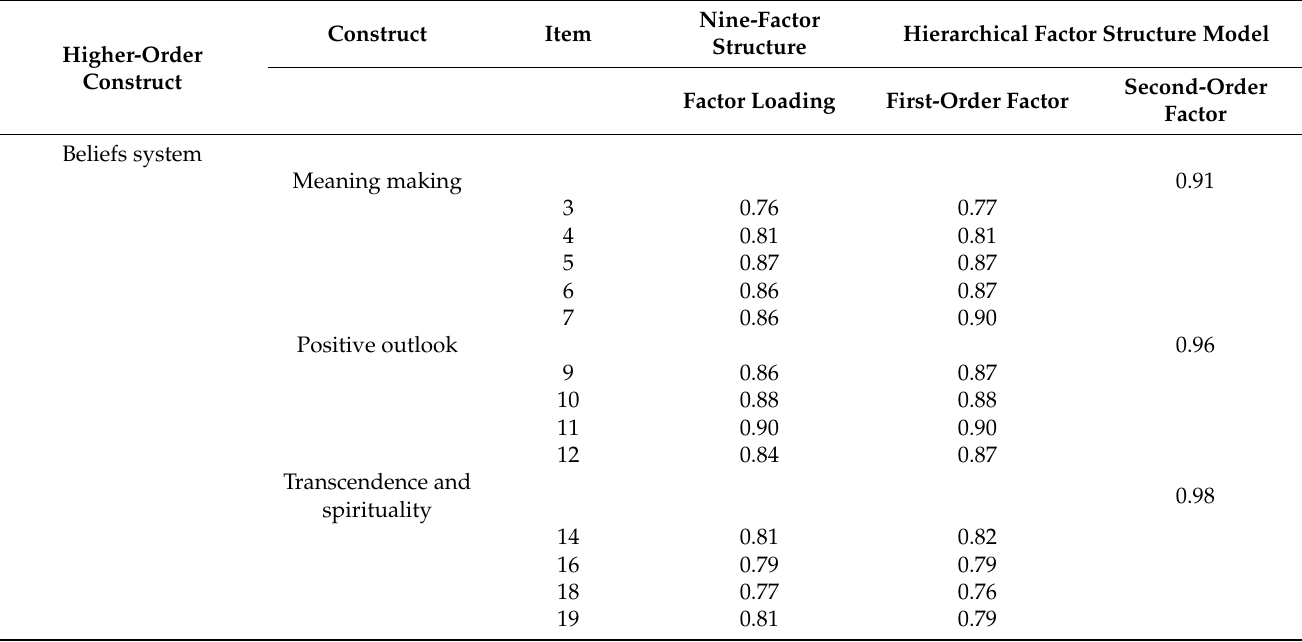
Table 5. Standardized Factor Loadings of Nine-Factor Structure Model and Hierarchical Factor Models of 35-item Chinese Family Resilience